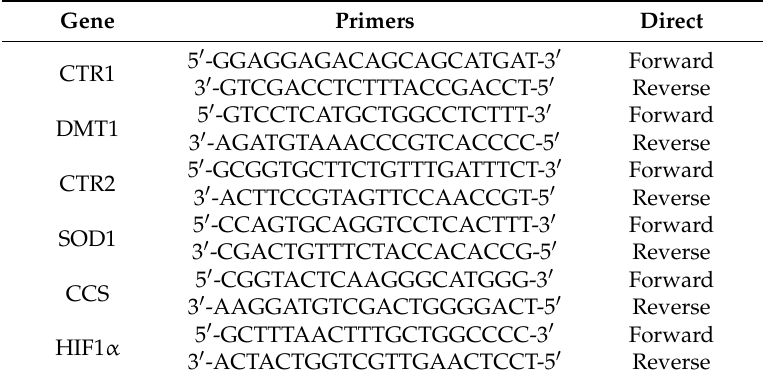
Table 1. Primer sequences used for qRT-PCR